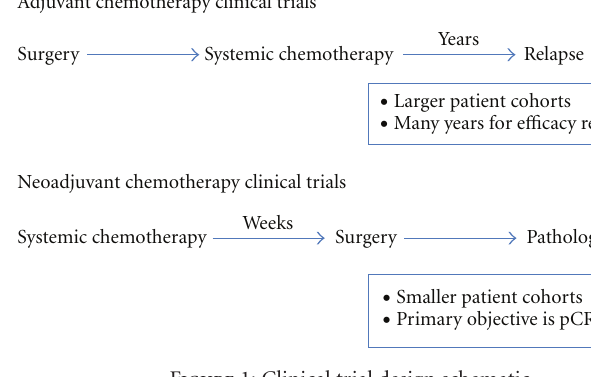
Figure 1: Clinical trial design